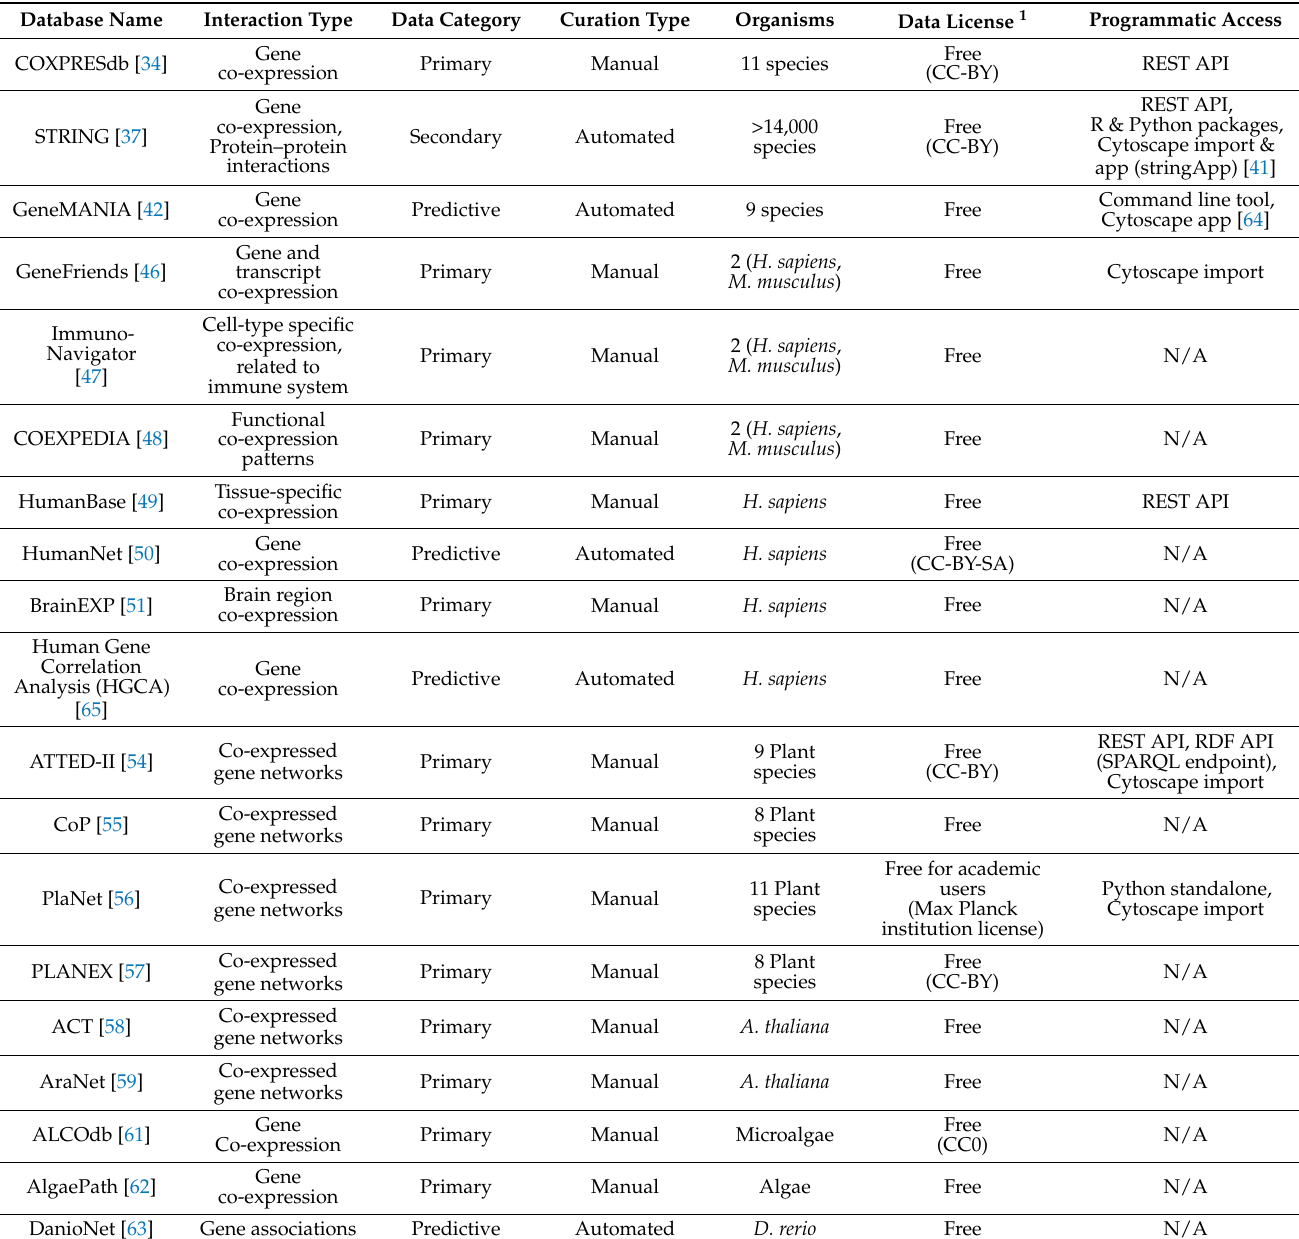
Table 1. Gene co-expression